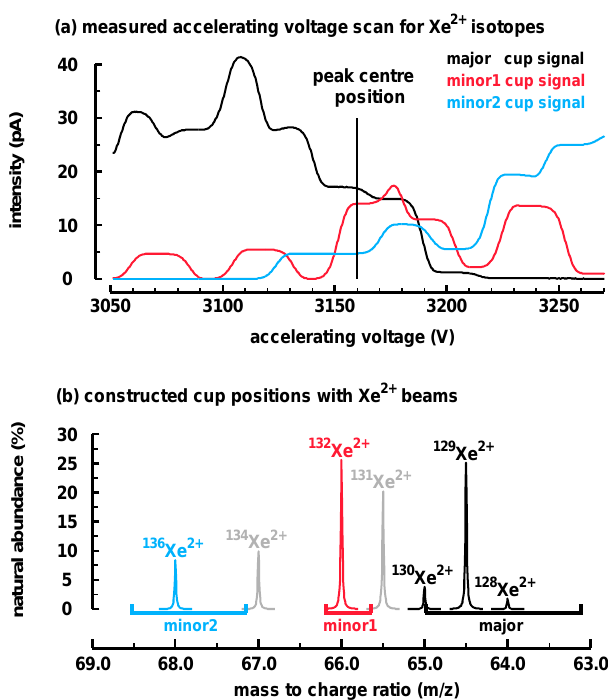
Figure 4. Mass spectrometer focusing to allow for isotope analysis of doubly charged Xe ions. (a) Accelerating voltage scan (note the magnet current was switched from 4000mA to 4800mA to allow for the collection of higher m/z ions in the cups) over the region where Xe 2 + ions hit the Faraday cups. At the selected peak centre position a shared plateau region and the subsequent stable measure- ment conditions allow for the simultaneous detection of 136 Xe 2 + in minor2 and 132 Xe 2 + in minor1 to calculate isotope ratios spanning 4 m/z units. (b) Constructed Faraday cup configuration and Xe ion beams at peak centre position illustrates that the centre position has to be selected carefully as many Xe 2 + ions are close to cup